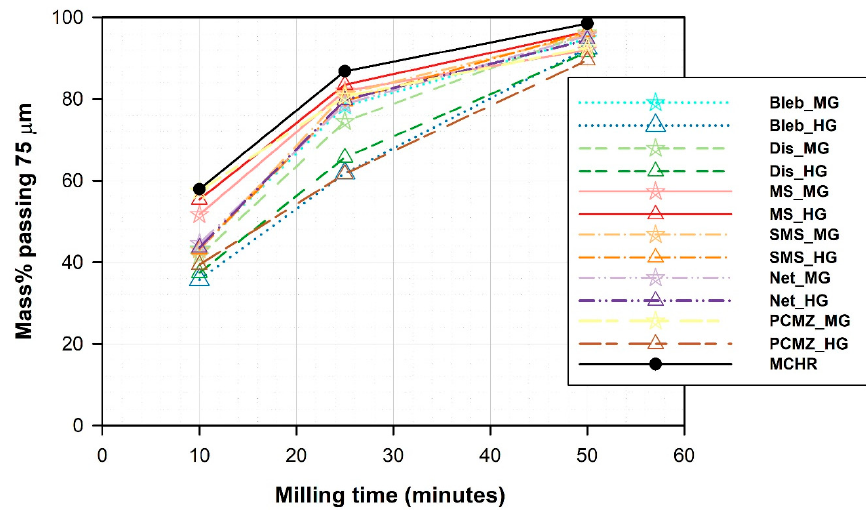
Figure 10. Cumulative mass % passing 75 µm sieve as a function of milling time for samples of the different ore textures collected from the MMZ and the PCMZ. The Bleb_HG and Dis_HG sulfide ore textural variants of the MMZ requires the long- est milling times for e.g., a P67 of 75 micron, while the massive sulfide ore variants require the shortest milling time (Figure 10).